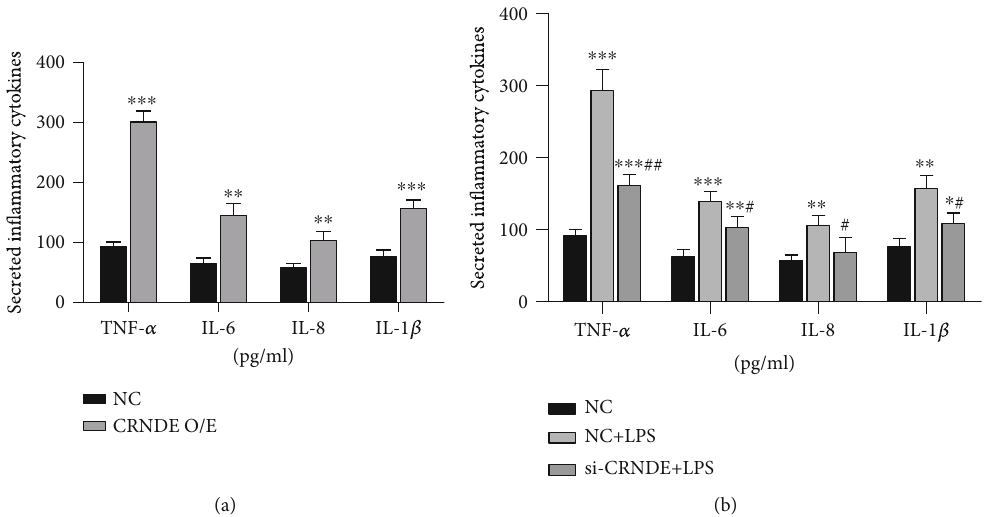
Figure 2: CRNDE-induced secretion of in fl ammatory cytokines by HK-2 cells. (a) Changes of cytokines in HK-2 cells that overexpressed CRNDE, compared with the control group, ∗∗ p < 0 : 01 and ∗∗∗ p < 0 : 001 . (b) Changes in CRNDE in fl ammatory cytokine levels in LPS-treated cells, compared with the control group, ∗ p < 0 : 05 and ∗∗ p < 0 : 01 , and compared with NC+LPS, # p < 0 : 05 and ## p < 0 : 01